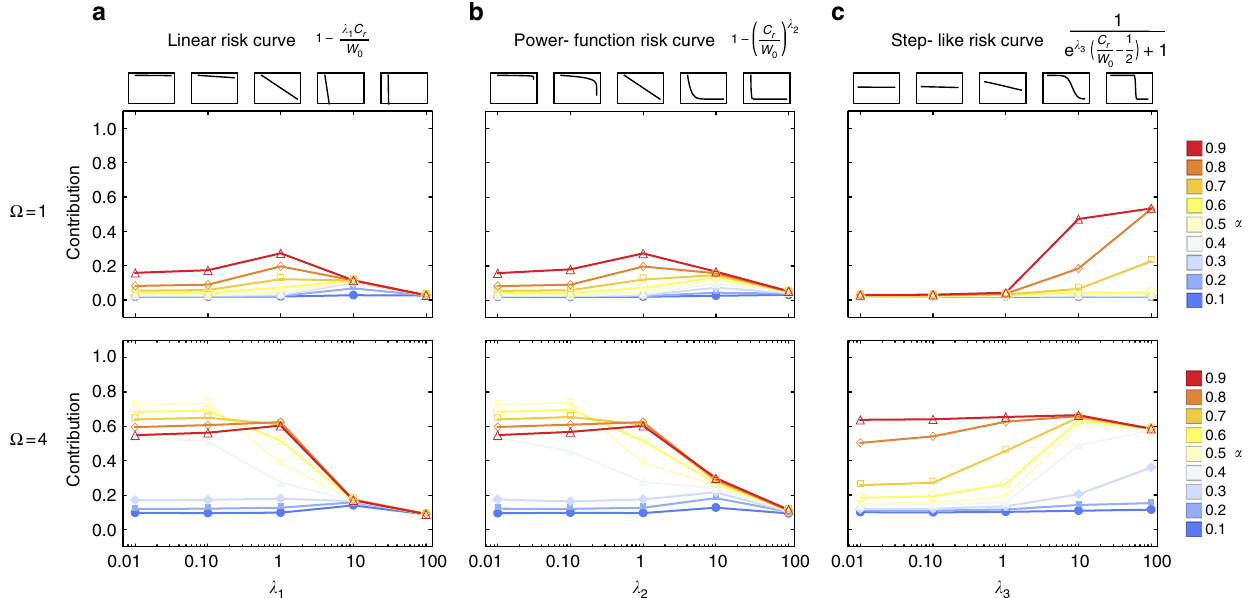
Fig. 5 Exploring the shape of risk curves. Average contributions for various risk curves and fractions of lost wealth α (see color code) are shown. In case the risk hits, each player, i , will lose α i W i , r for each loss event. The shape of the curve is regulated by parameter λ on the x -axis. a In the case of linear risk curves and Ω = 1, contributions are largest at intermediate values of λ (contributions are small if the curve has a steep slope). b Similar effects on contributions apply to the power function risk curve. c The step-like risk curve with lower initial risk for smaller values of λ 3 shows that contributions are rising in α (games are between two individuals, initial wealth of both players W 0 = 2, population size N = 100, averages over 10 5 generations, 1000 games per generation, mutation rate μ = 0.03, and the standard deviation for mutations in the thresholds τ r is set to σ = 0.15), see ref. 20 for a similar